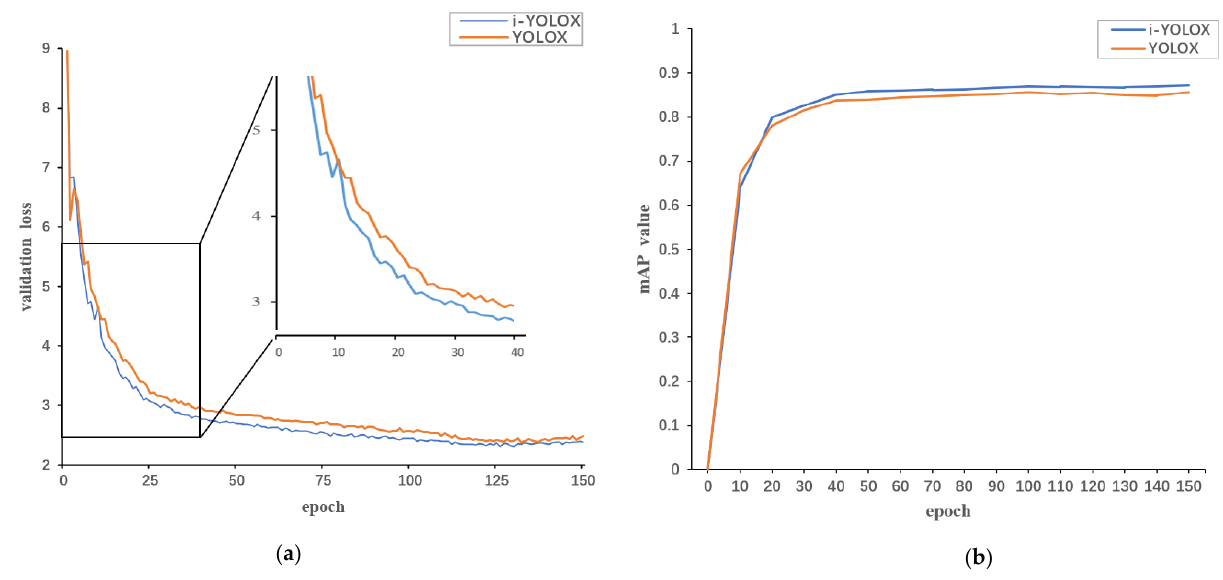
Figure 10. ( a ) is validation loss curve plot, ( b ) is mAP curve plot.